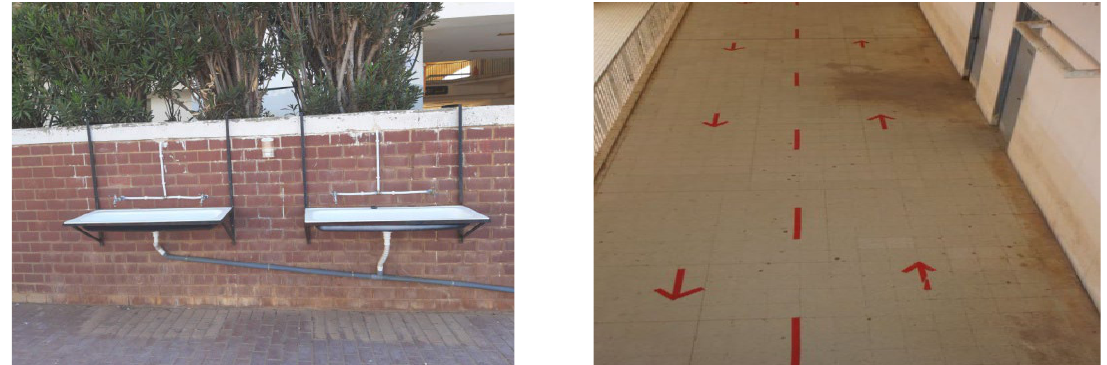
Figure 5. Hygiene actions in university – Seiso action (left) and Seiketsu action